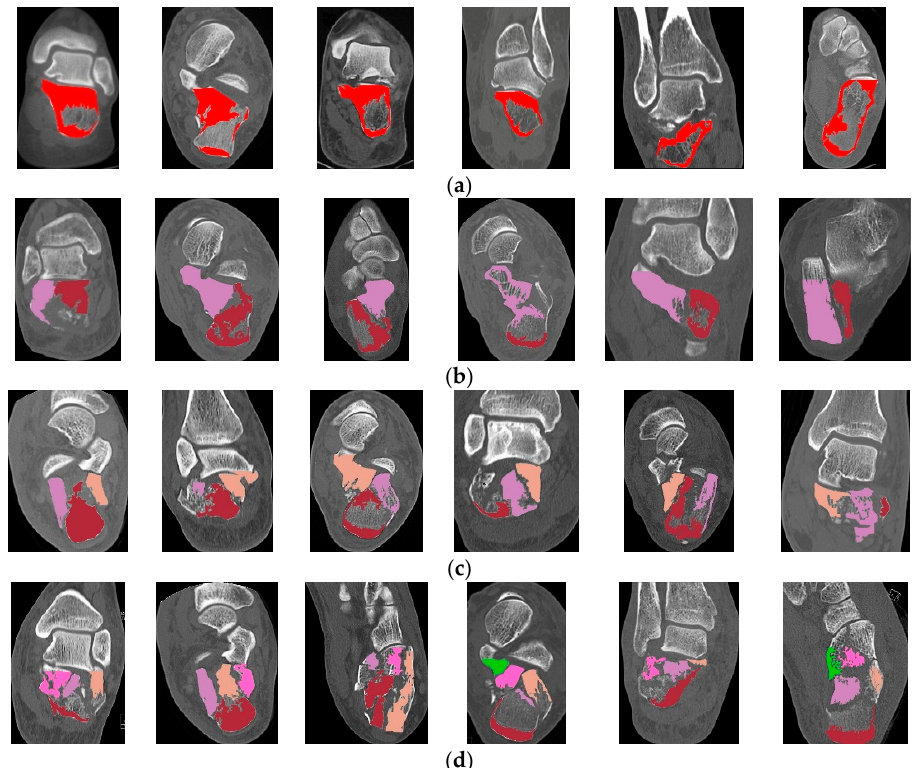
Figure 18. Segmentation result of the calcaneal fractures based on Sanders classification: ( a ) Type I; ( b ) Type II; ( c ) Type III; and ( d ) Type IV.